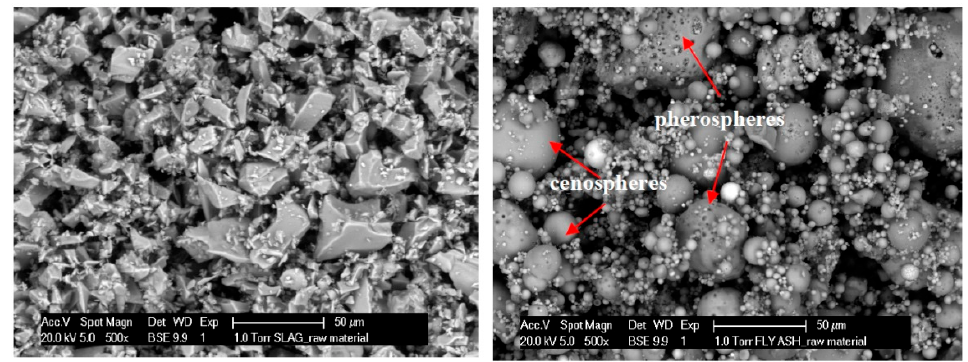
Figure 1. ESEM-BSE images of GBFS ( left ) and FA ( right ) particles.